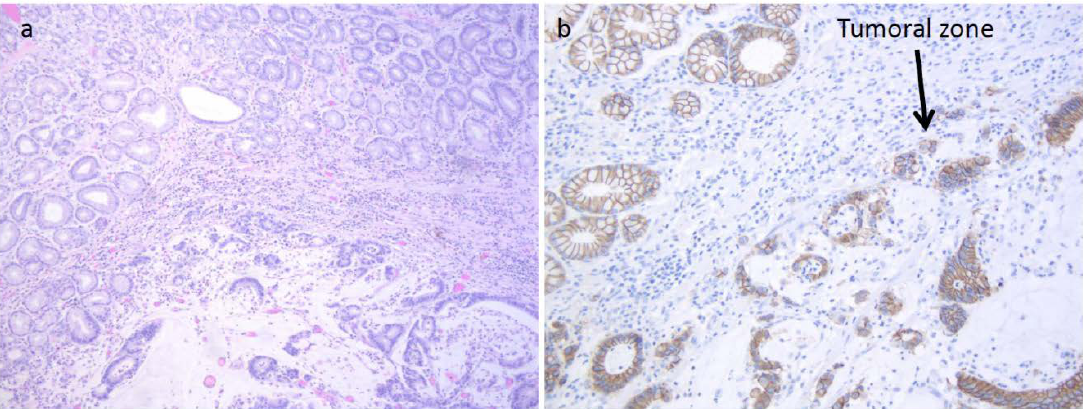
Figure 2. Patient 1: ( a ) Neoplastic cells showing diffuse solid growth and focal vague glandular appearances. H&E staining, original magnification 10 × ; ( b ) Reduction of E-cadherin expression by immunohistochemical staining, original magnification 20 × .